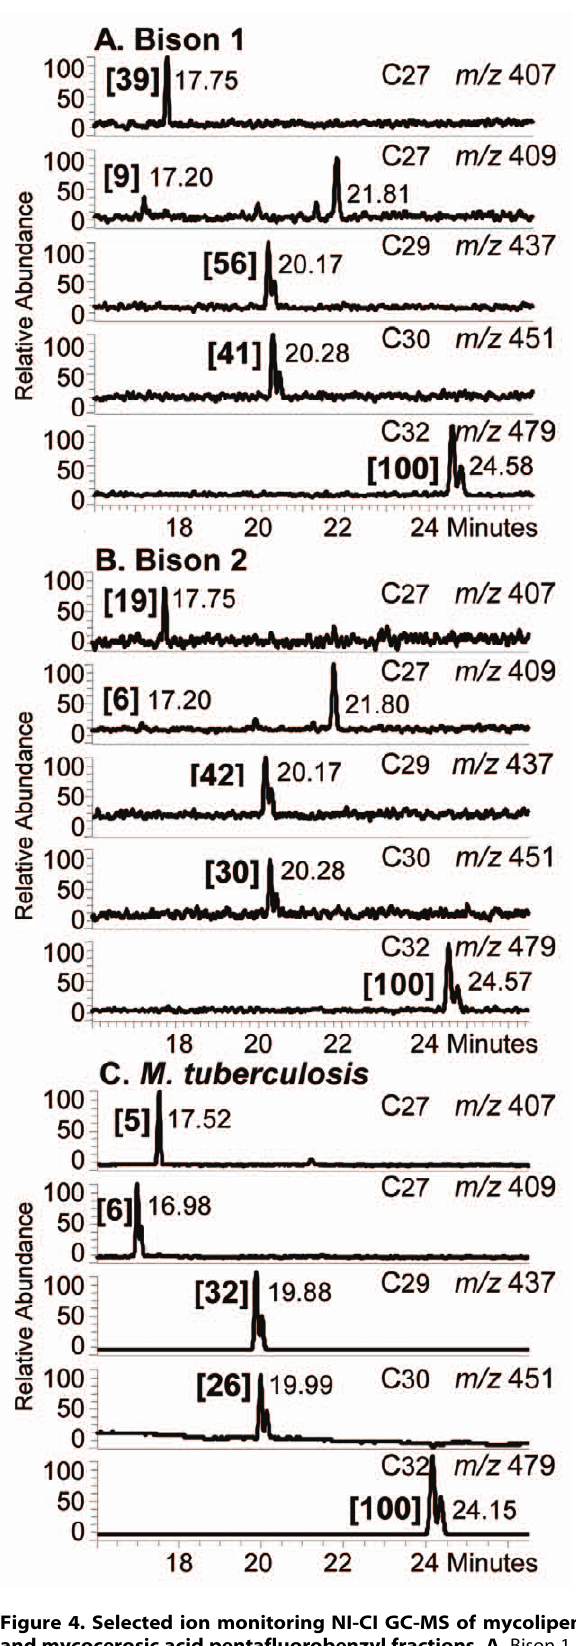
Figure 4. Selected ion monitoring NI-CI GC-MS of mycolipenic and mycocerosic acid pentafluorobenzyl fractions. A. Bison 1. B. Bison 2. C. Standard M. tuberculosis. The m/z 407 (mycolipenate),